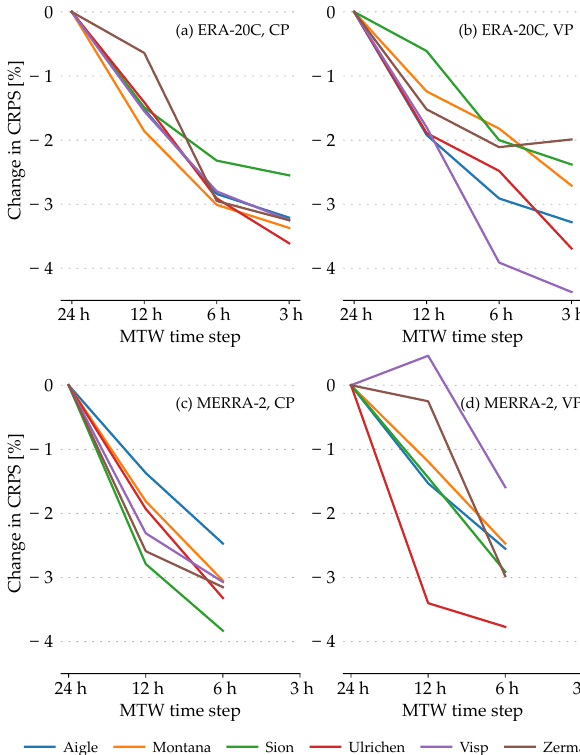
Figure 10. The same as Fig. 9 but for the 2Z-2MI method.